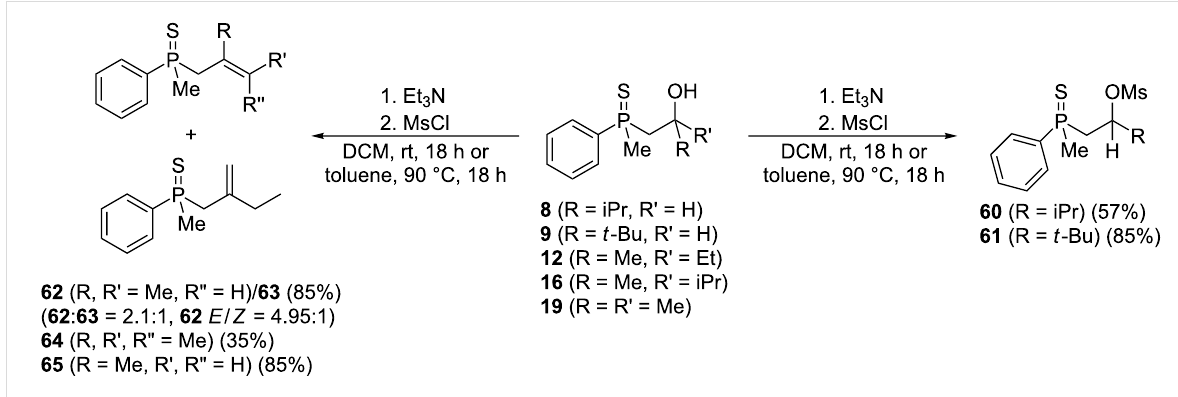
Scheme 6: Synthesis of the alkenylphosphine sulfides used in study.